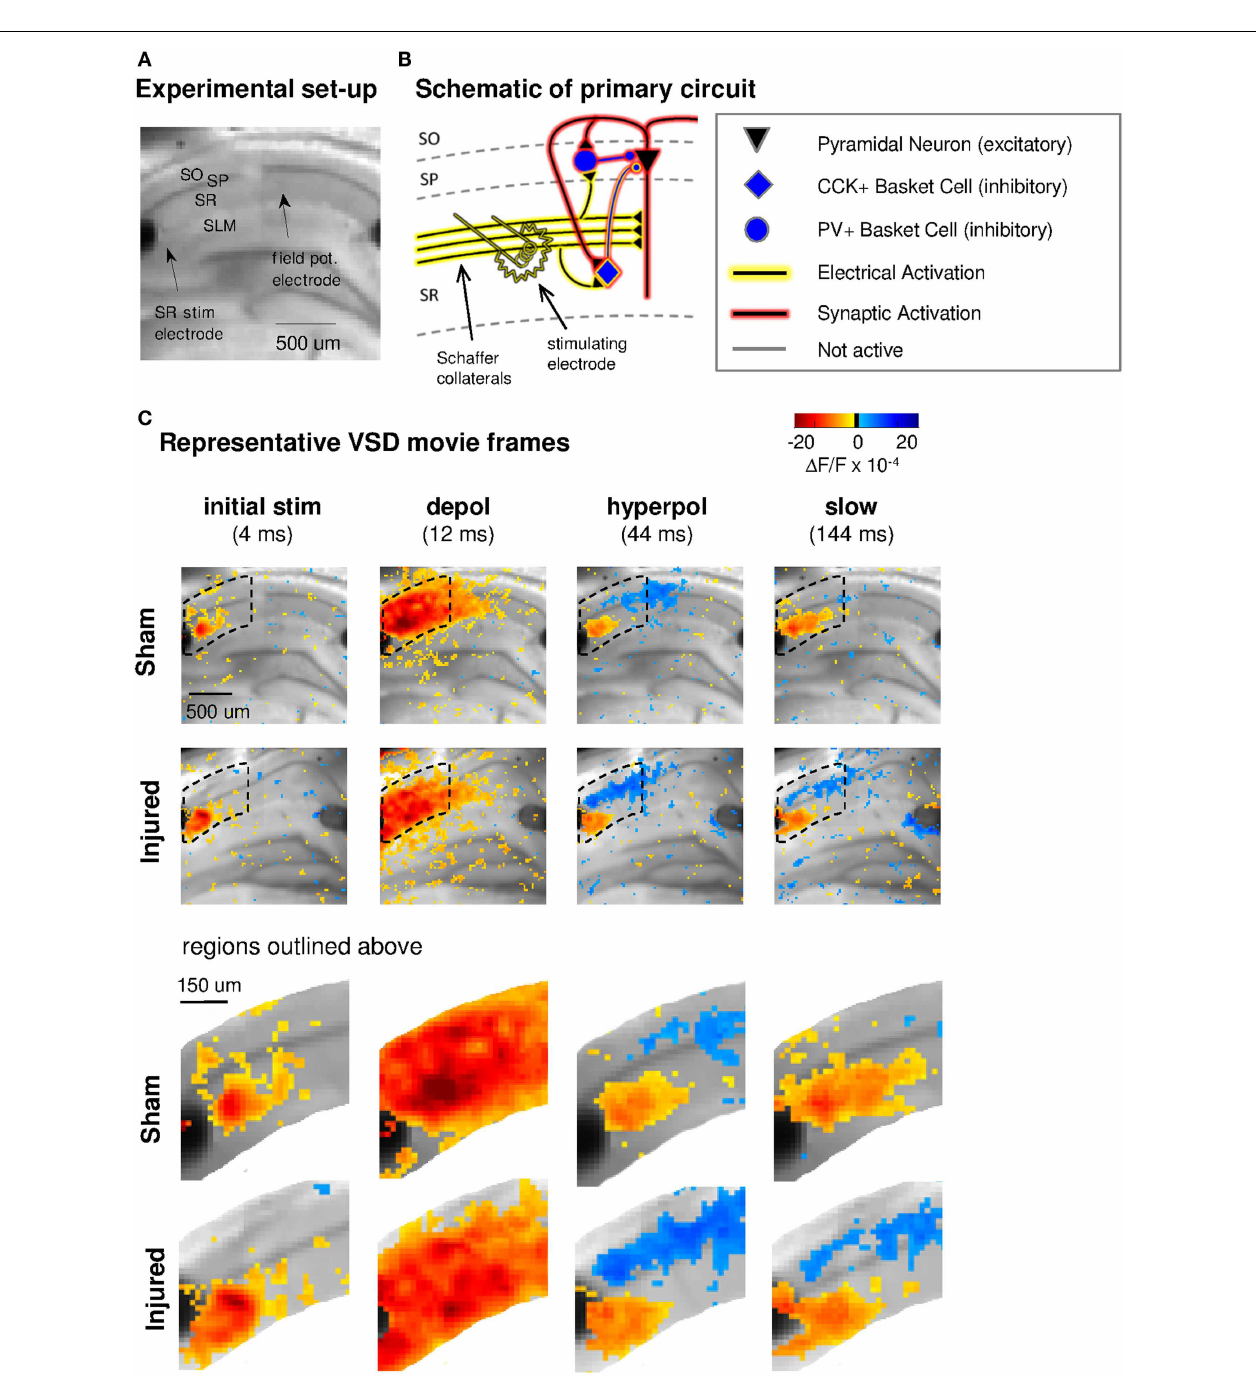
here, with SO uppermost, then SP and SR and (when shown) SLM. (B) Schematic of CA1 pyramidal neuron and basket cell activation by SR stimulation in aCSF. Note distinction between direct “electrical activation” shown by yellow highlight, and “synaptic activation” shown by red highlight. “Electrical activation” refers to the direct depolarization of cell membranes by the current flow from a stimulating electrode, independent of any subsequent synaptic depolarization. “Synaptic activation” refers to depolarization initiated by synaptic currents. Legend here applies also to schematics in